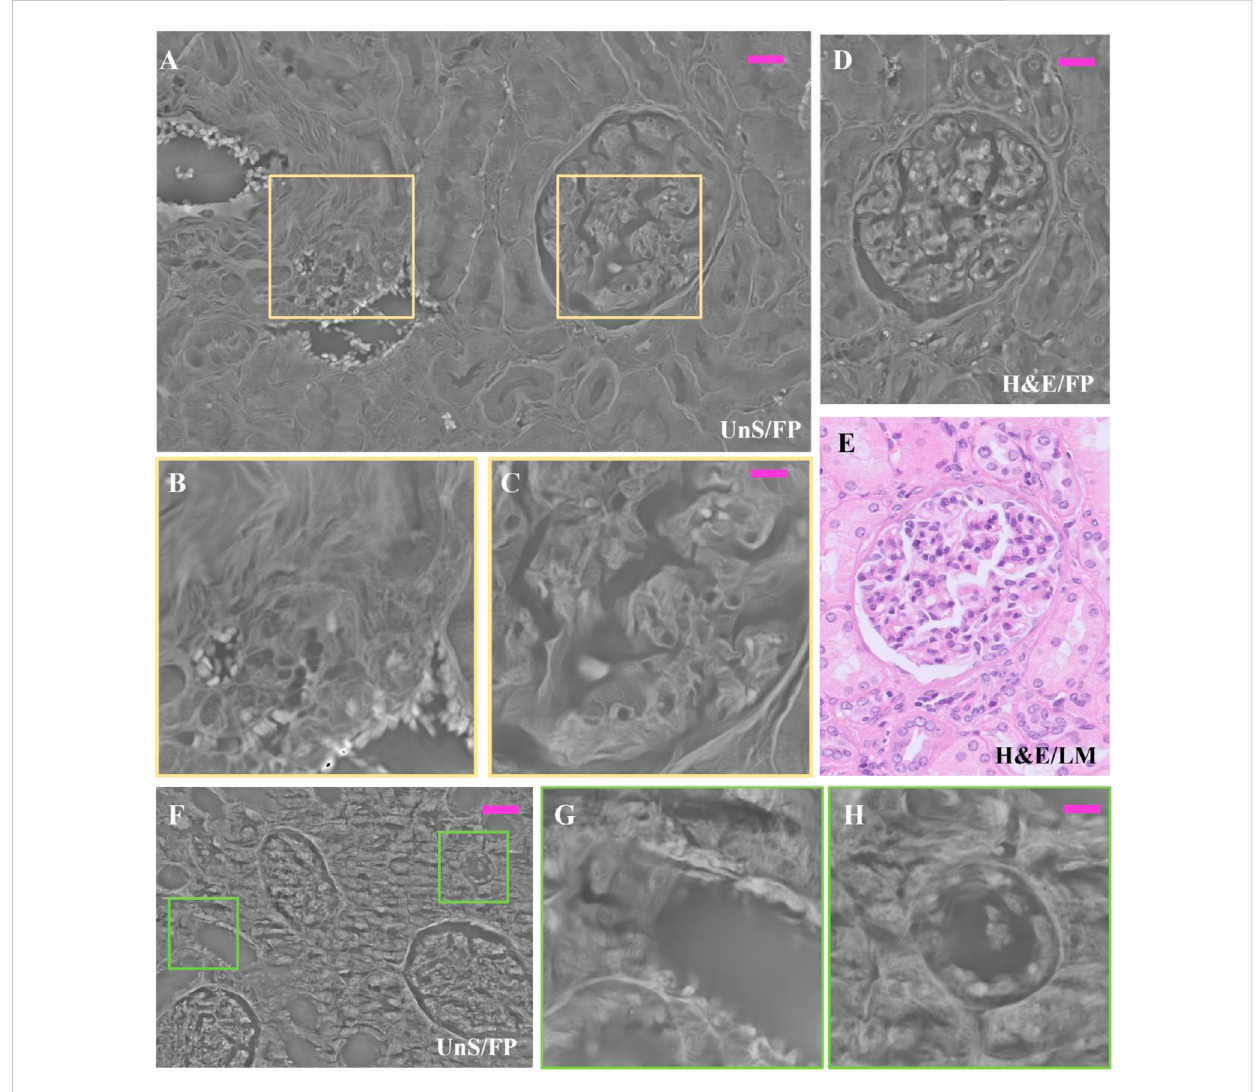
FIGURE 5 Unstained and H&E-stained renal tissue details: (A) Unstained renal tissue captured by FP, 3 µm thick, whose zoomed patches delimited by the purple boxes are respectively: (B) the smooth muscle tissue of a vasal section; and (C) the inner structure of the glomerulus; (D) same H&E-stained glomerulus captured by FP, 3 µm thick; (E) H&E-stained glomerulus captured by LM, 3 µm thick as gold standard; (F) different FP renal tissue slide, 3 µm thick and unstained; (G,H) renal tubule sections, zoomed in. The scale bar in (A,D) is 25 μ m, while in (B,C,G,H) is 12 μ m; in (F) is 50